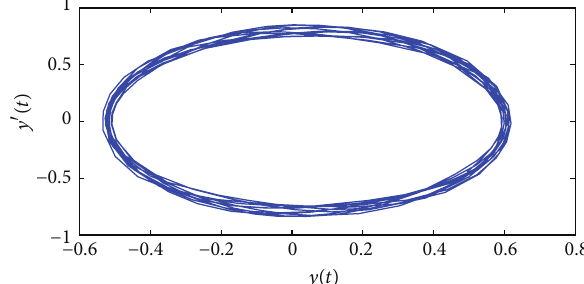
Figure 4: Phase response of state variables 𝑥(𝑡) and 𝑦(𝑡) .